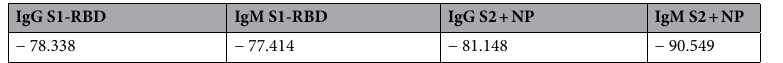
Table 8. Value of the likelihood function for each of the 4 models presented in Tables 4, 5, 6 and 7.